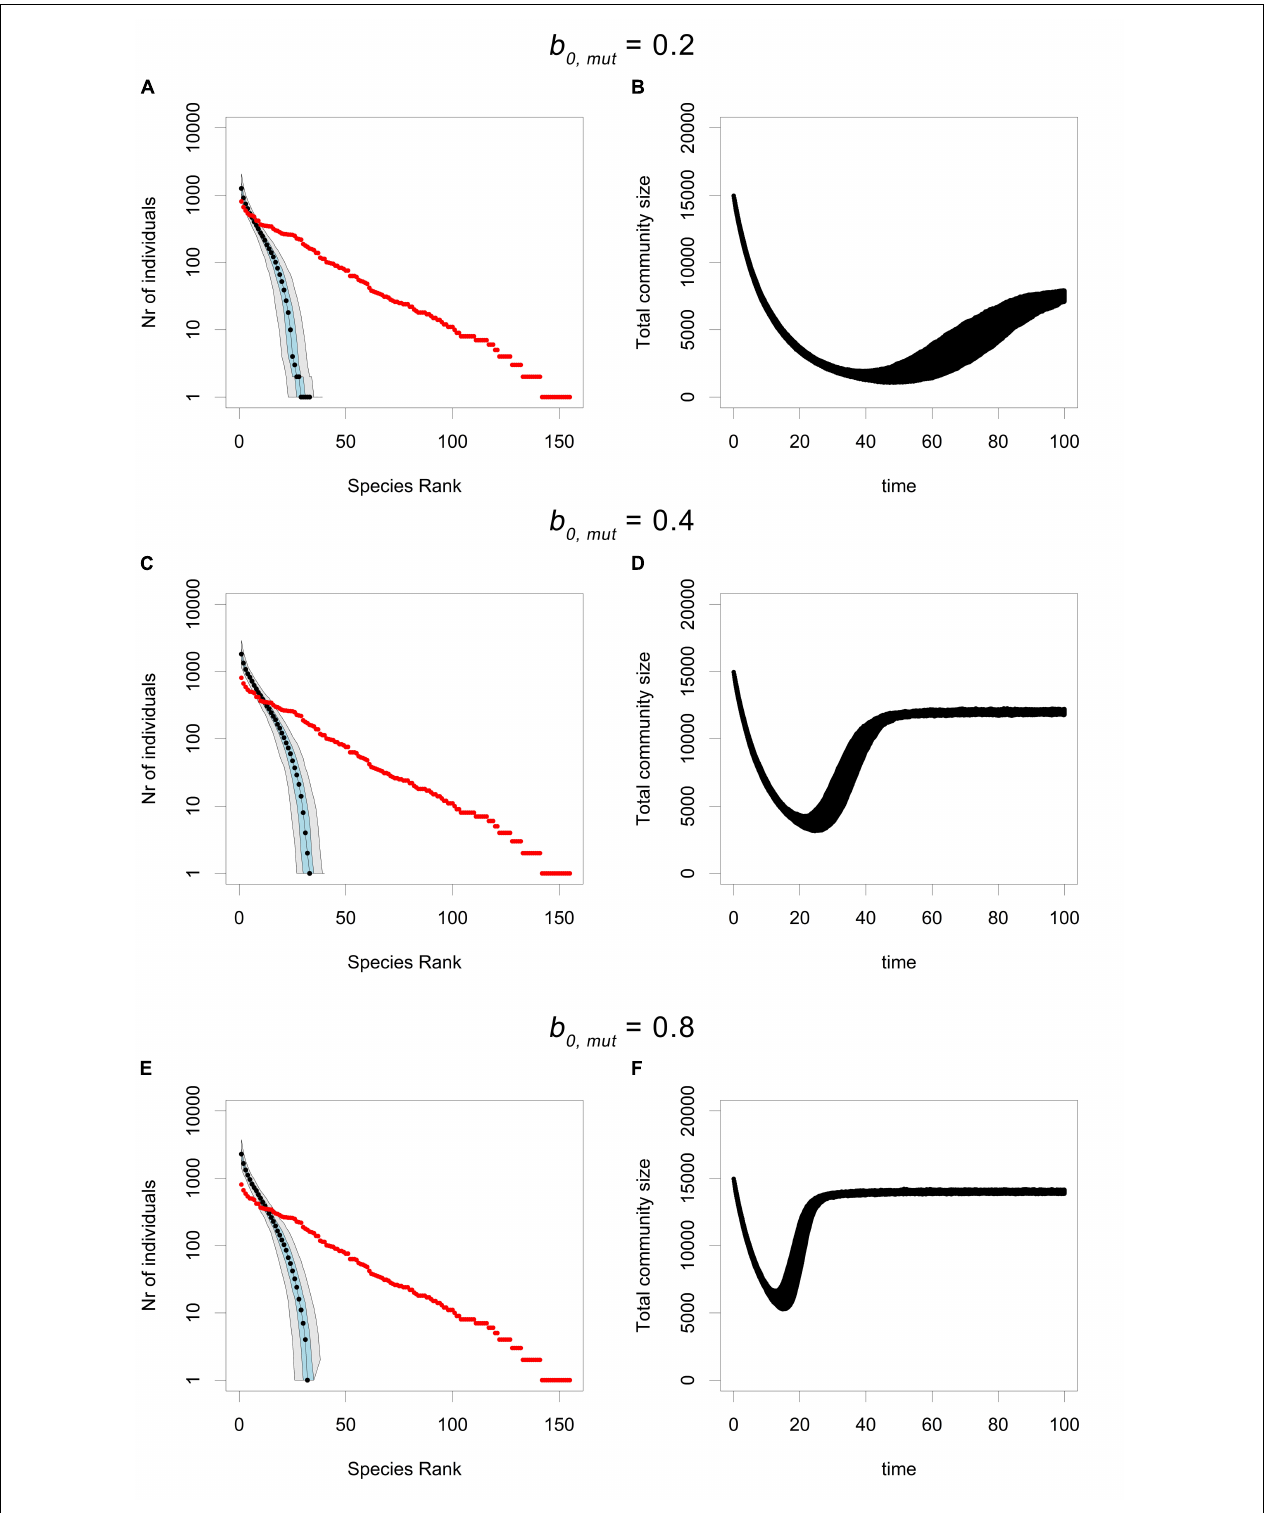
FIGURE 4 | The RAC under CWR processes with different mutant birth probabilities ( b 0 , mut ). All simulations were performed using the parameters b 0 , res = 0.05, d = 0.1, K = 16000, and µ = 0.0005. In (A,B) b 0 , mut = 0.2, for (C,D) b 0 , mut = 0.4 and in (E,F) b 0 , mut = 0.8. Panels (A,C,E) show the RAC’s after 100 units of time, where the median is shown in black, the 25th and the 75th percentile are shown in blue and the 5th and the 95th percentile are shown in gray, with the input community plotted in red. (B,D,F) Display the trajectories of total community size over time. All plots are based on 500 simulations.